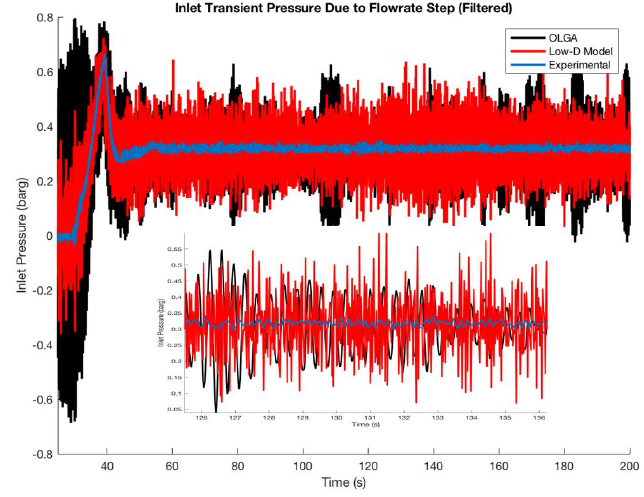
Figure 9. Experimental vs. simulations (Inlet Pressure, liquid/case 1).